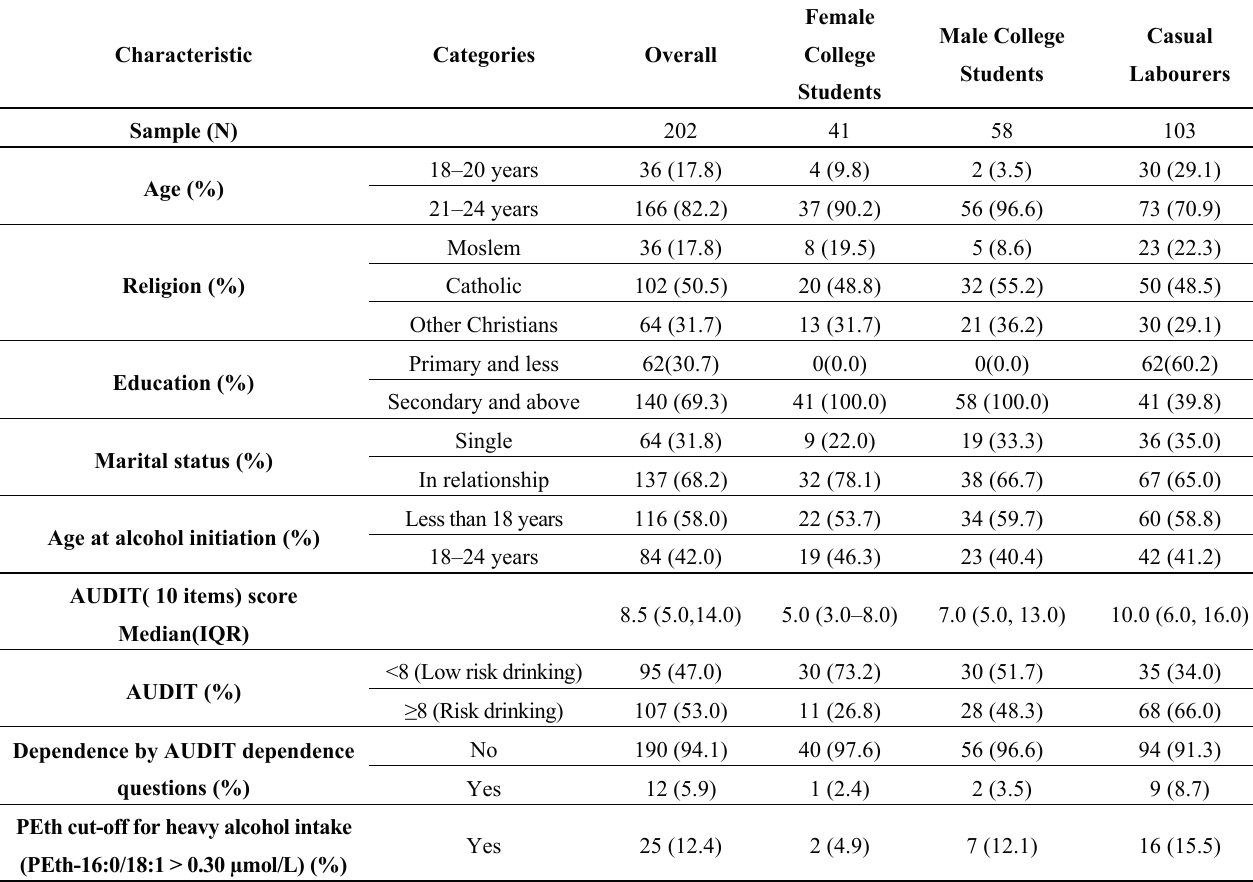
Table 1. General characteristics of the study